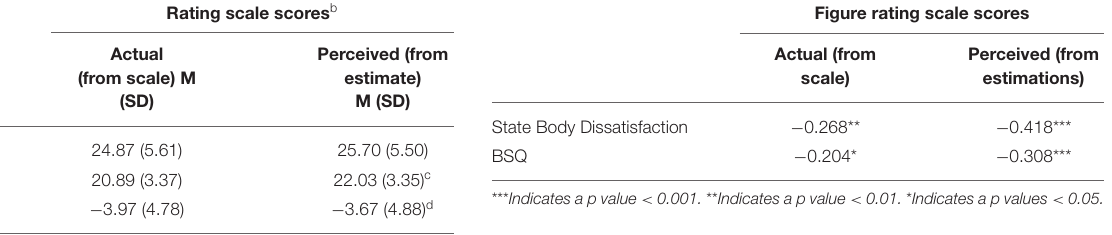
TABLE 4 | Correlations (r) between body dissatisfaction scores and figure rating scale scores, controlling for participant BMI. Figure rating scale